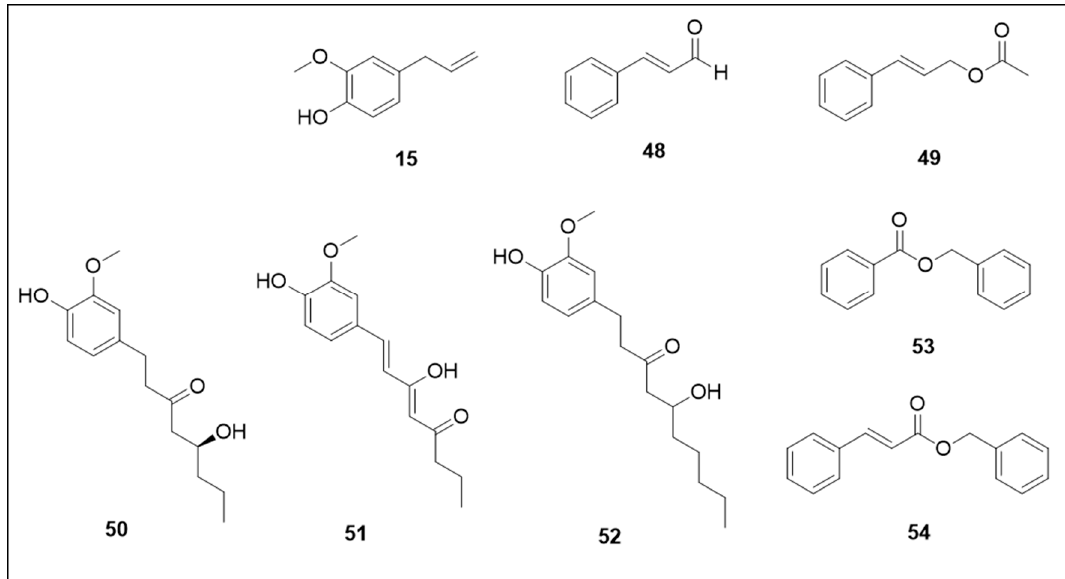
Figure 8. Phenylpropanoids and phenolic derivatives active against Ae. aegypti .